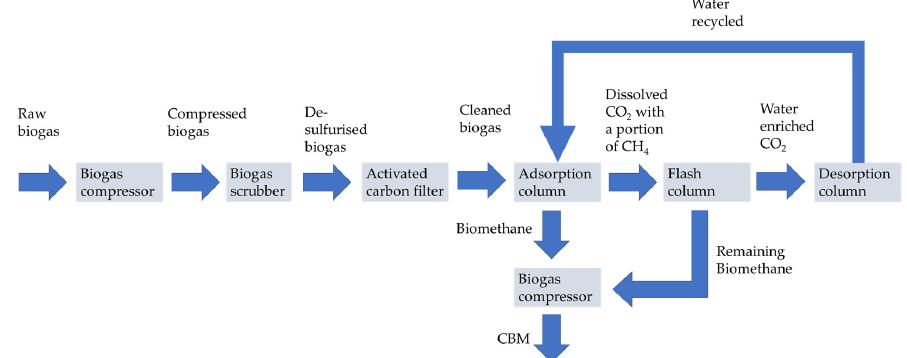
Figure 10. MS biogas-to-biomethane upgrading pathway. In addition to MS technology, a scrubber and a drier have been added to remove moisture and H 2 S. The activated carbon filter has also been added to remove traces of H 2 S and volatile organic compounds (VOCs). A compressor is preliminarily added for compressed biomethane.